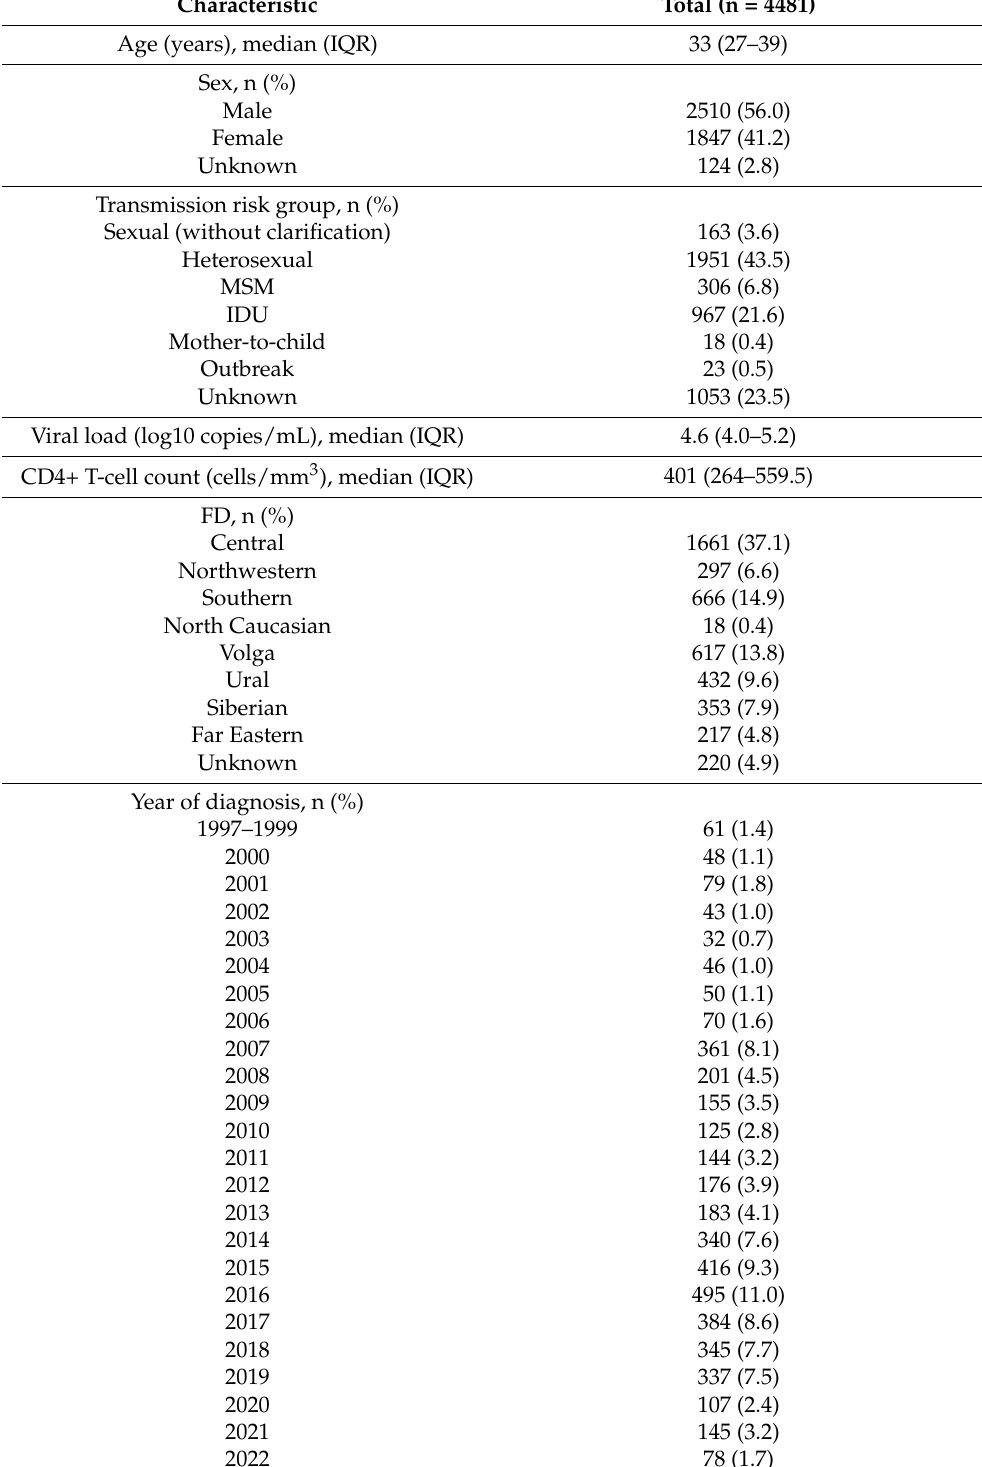
Table 1. Epidemiological and clinical characteristics of the study